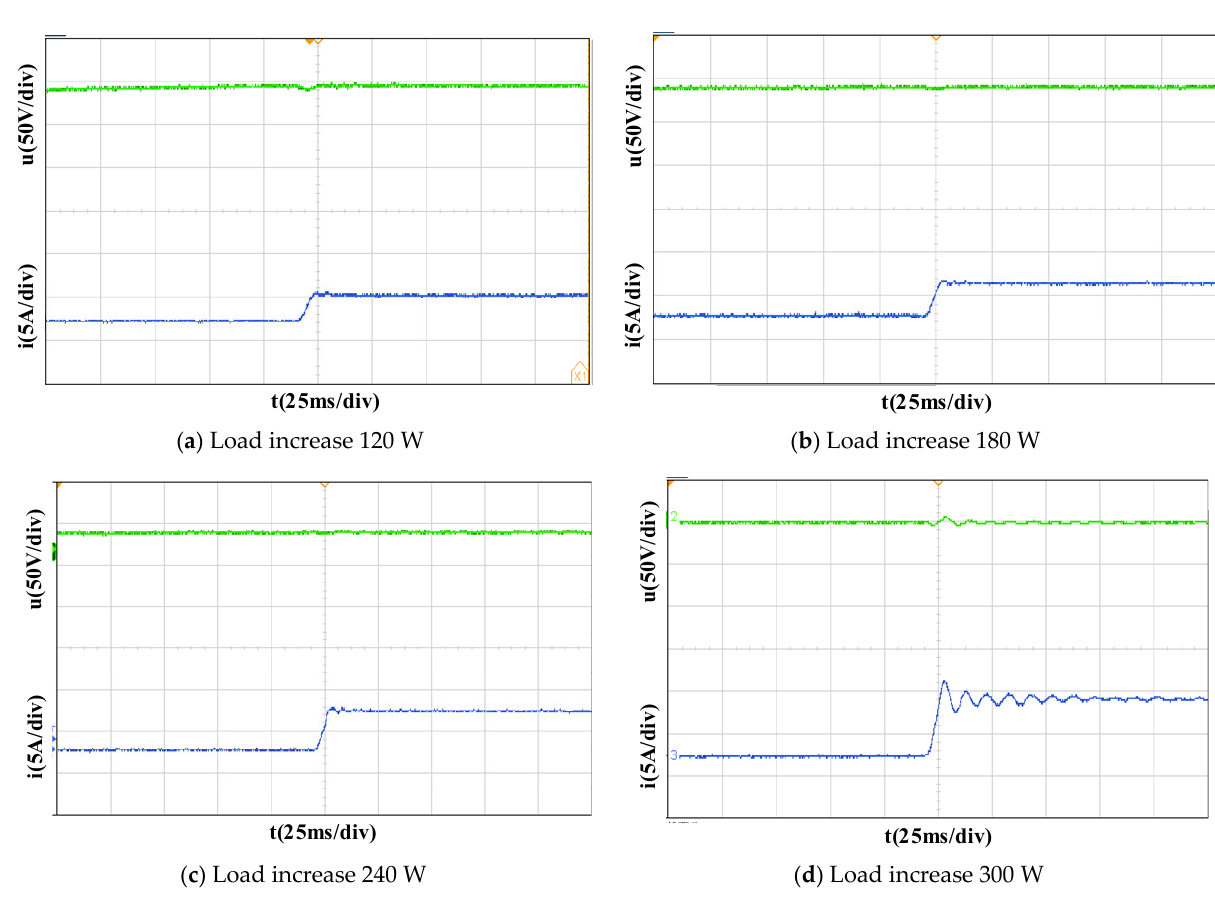
Figure 8. Experimental waveform under load suddenly increases, ( a ) Load increase 120 W, ( b ) Load increase 180 W, ( c ) Load increase 240 W, ( d ) Load increase 300 W. In Figure 8, the green curve is the DC bus voltage response waveform, and the blue curve is the battery current response waveform. In Figure 8a–d, the output current of the battery stabilizes at 2 A at the beginning, and rapidly increases to 4.4, 5.6, 6.6, 7.8 A after the load suddenly increases. The fluctuation range of DC bus voltage caused by the load Figure 9 is response waveforms of the DC bus voltage and battery terminal current when the load suddenly decreases under different load conditions. u ( 50 V / d i v ) i ( 5 A / d i v )